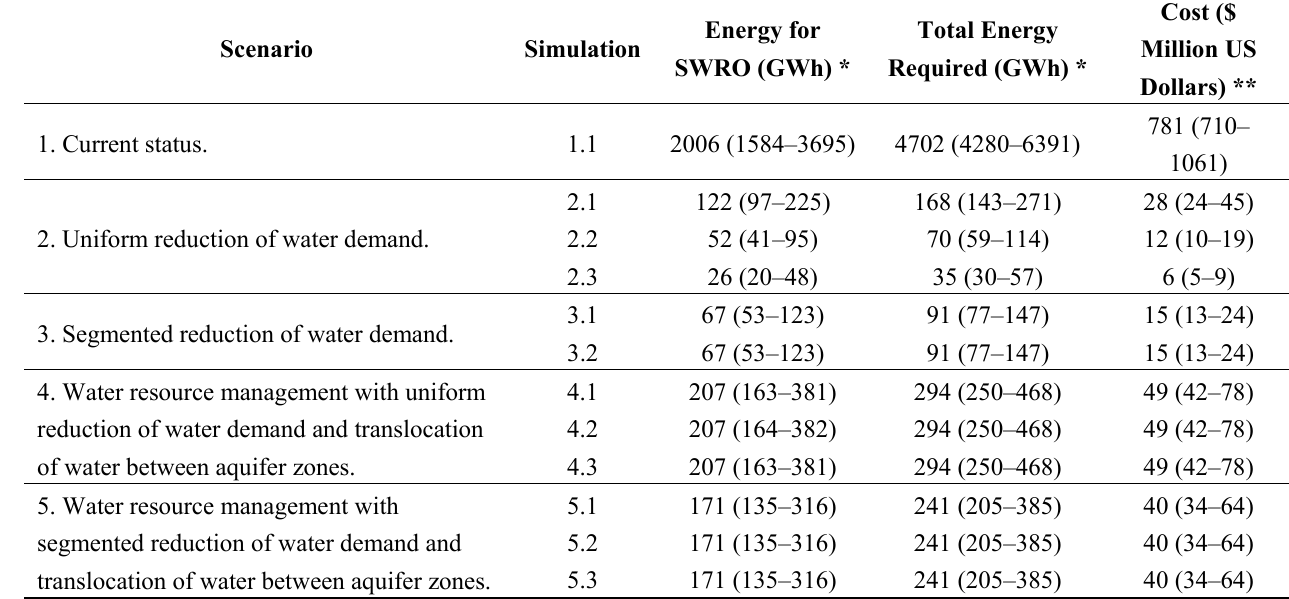
Table 6. Energetic requirements and corresponding costs for each IWRM